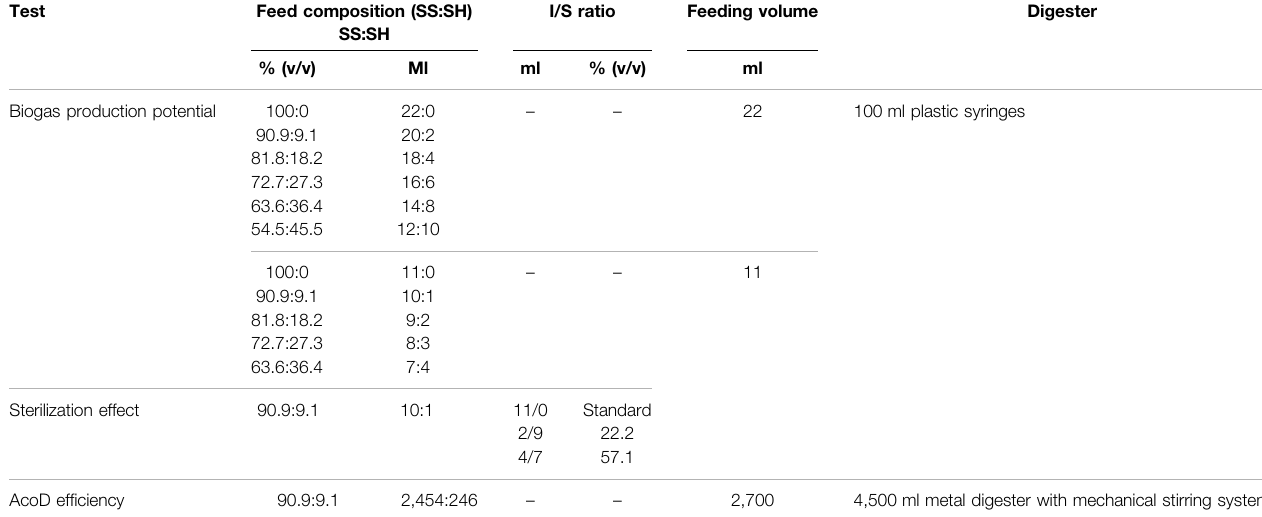
TABLE 1 | Tests performed during the experimental procedure.